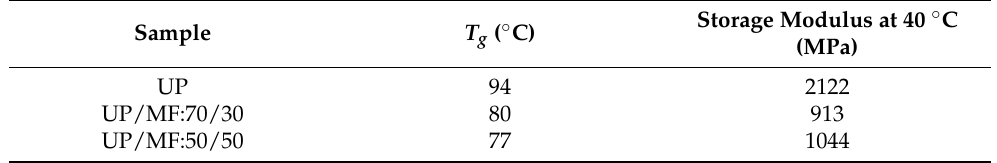
Table 3. T g s and storage moduli of cured cast resin samples of UP and UP/MF blends from DMTA.